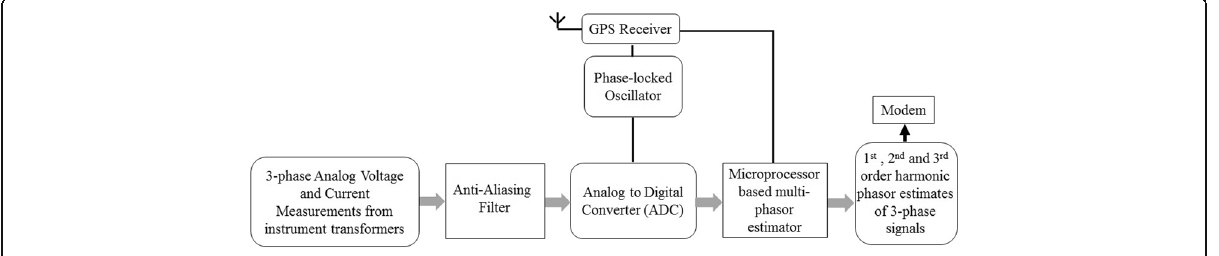
Fig. 1 Block diagram of a multi-phasor measurement unit